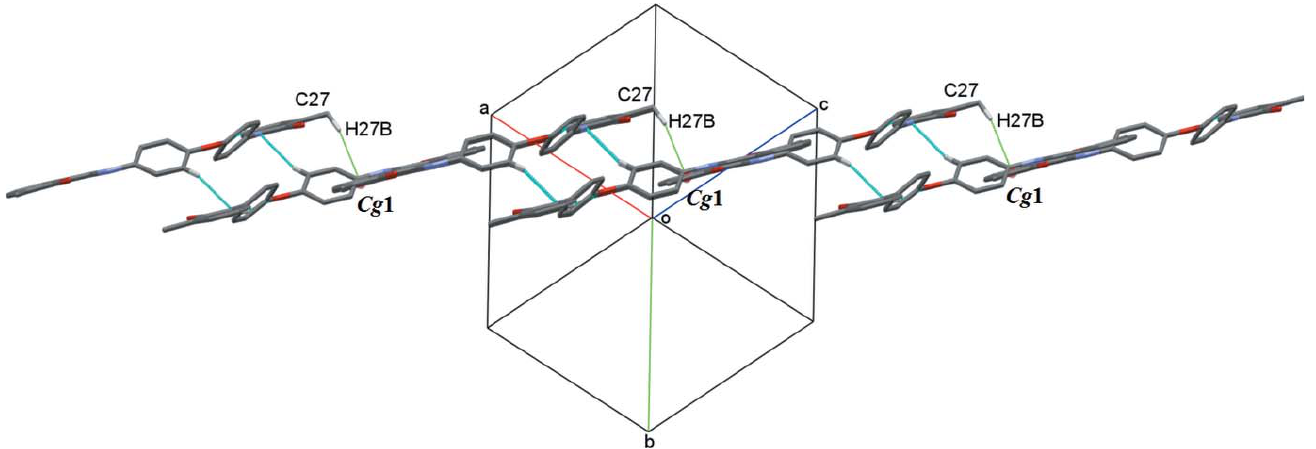
Figure 3 A view along (111) showing weak C—H (cid:2)(cid:2)(cid:2) (cid:2) (green dotted lines) supramolecular interactions in the title compound.